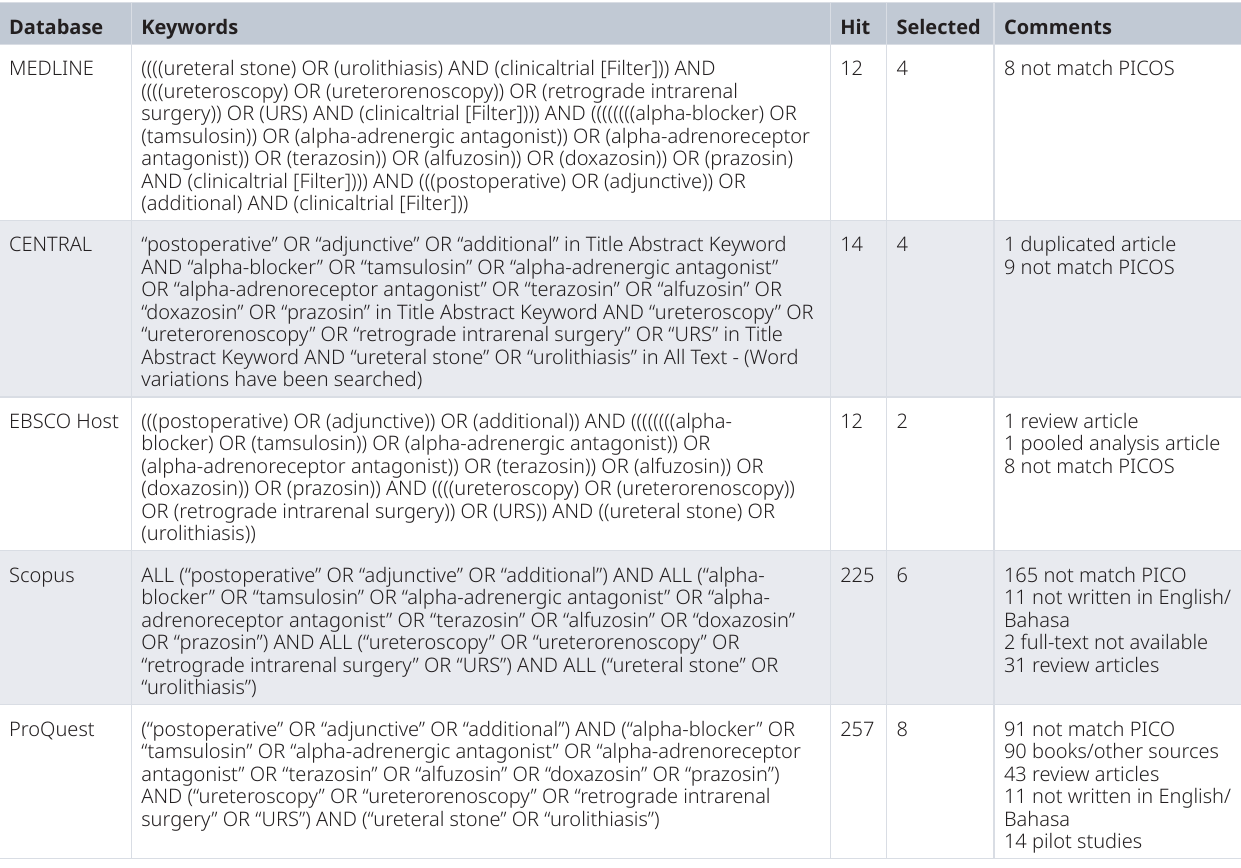
Table 1. Summary of article identification and exclusion from each